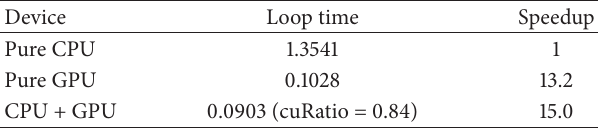
Table 4: Speedup ratio (1NP, problem size 512 × 256 × 256).